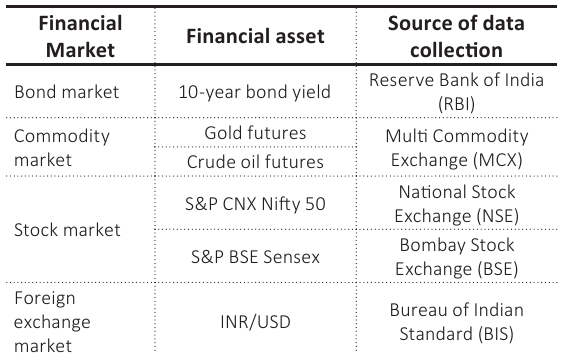
Table 1. Description of